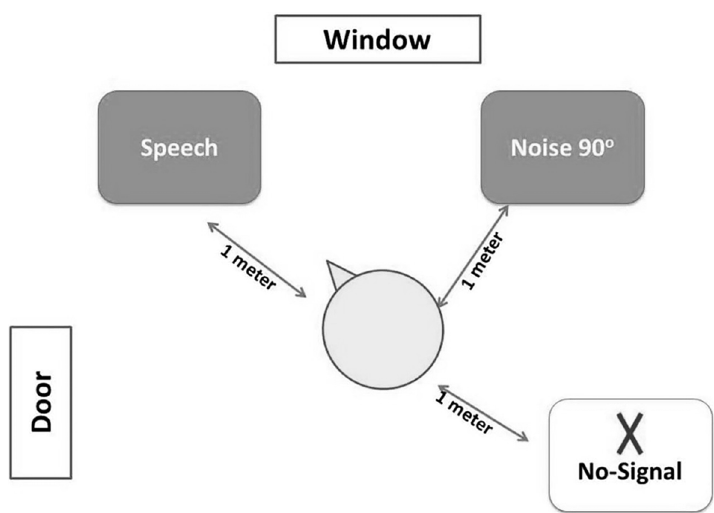
Fig. 2 Signal and noise arrangement in noise 90° azimuth